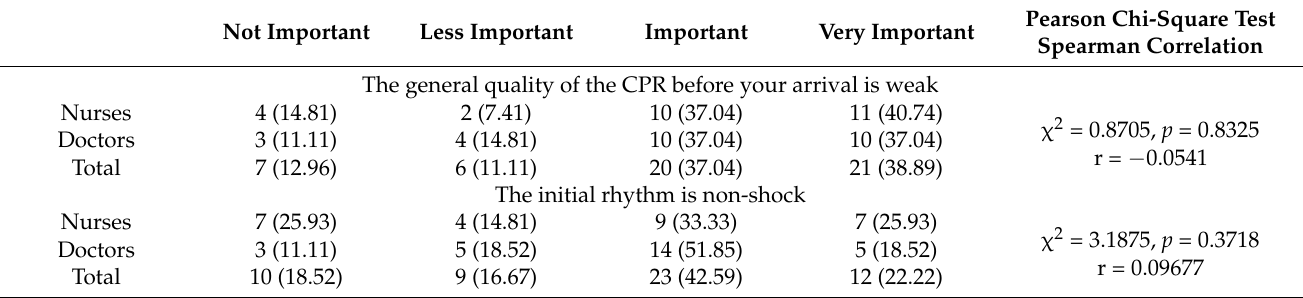
Table 3. Factors influencing perceptions regarding the opportunity for